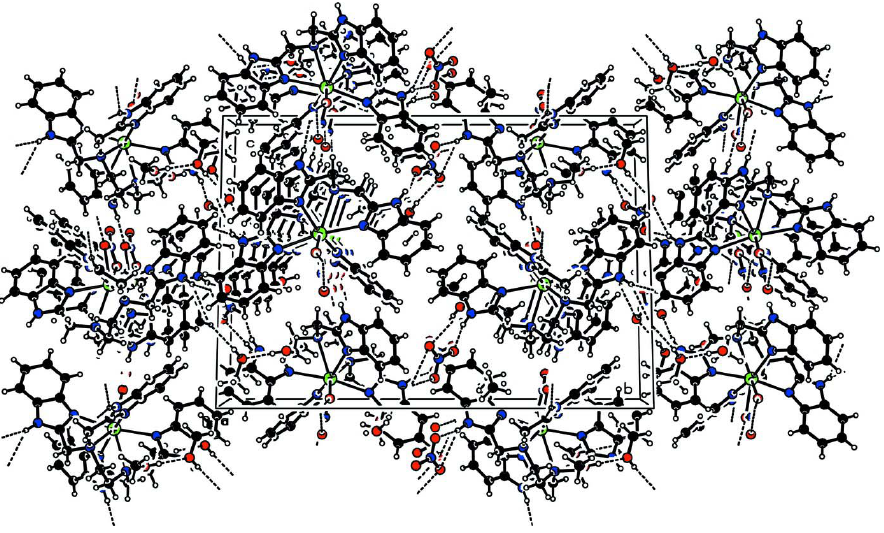
The crystal structure of the title compound, viewed along the a axis. Hydrogen bonds are shown as dashed